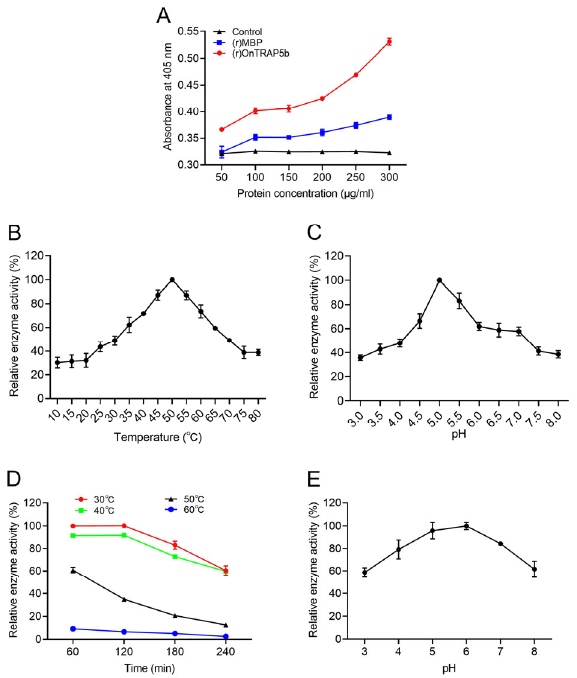
Figure 5. Phosphatase activity of (r)OnTRAP5b. Analysis dependence on protein concentration ( A ); optimum temperature ( B ); optimum pH ( C ); temperature stability ( D ); and pH stability ( E ) of (r)OnTRAP5b. Phosphatase activity of (r)OnTRAP5b were expressed as percentages of the relative phosphatase activity. Data are presented as means ± SD ( n = 3). n , the number of times the experiments were